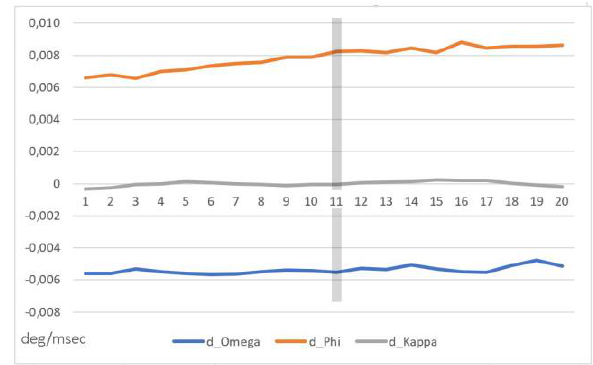
Figure 3c : Angular motion of the camera registered from the IMU (# 19103, London, GSD: 3,5 cm). d_omega = -5,5 °/sec, d_phi = 8,2 °/sec, d_kappa = 0,06 °/sec. Read-out interval is 5 msec, the exposure corresponds to position